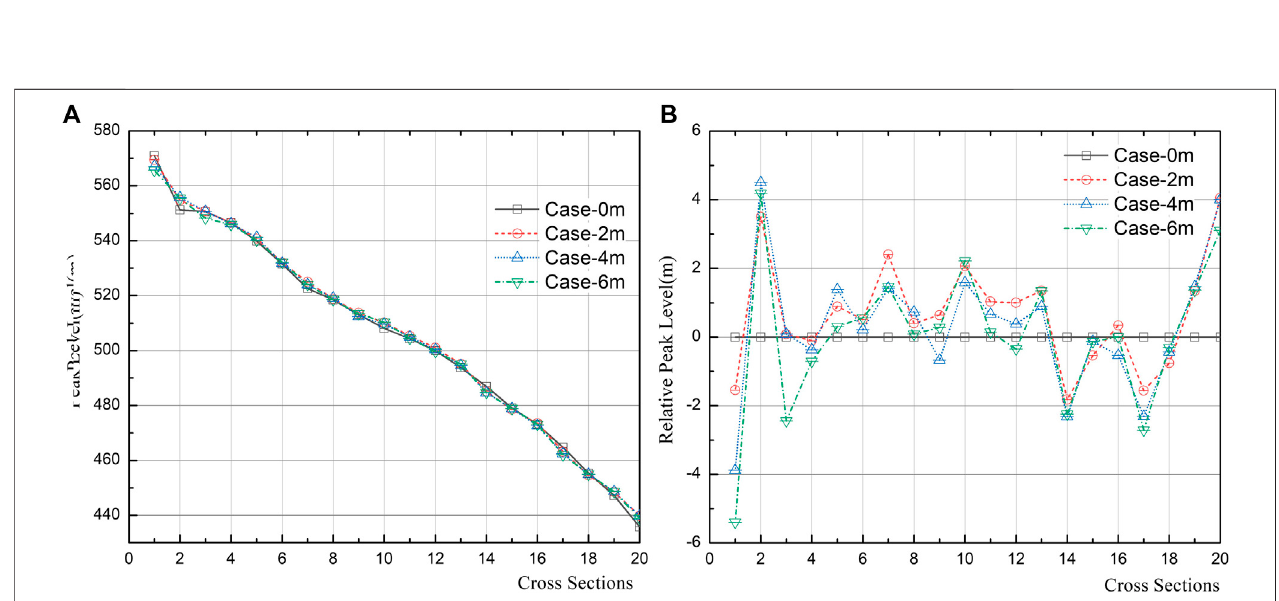
FIGURE 6 | Simulated arrival time (A) and relative arrival time (B) of fl ood wave at cross sections.